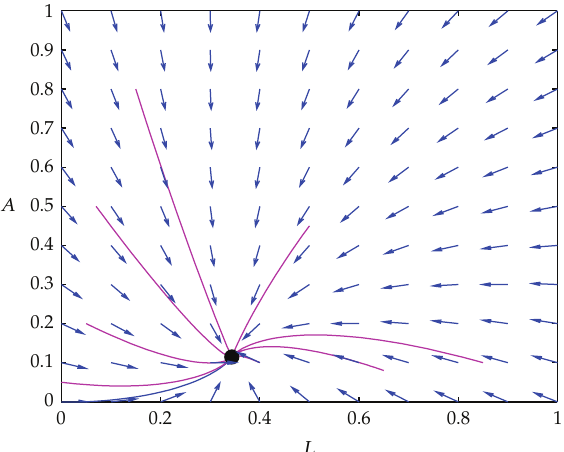
Figure 1: Phase portrait for the system given in Example 3.8.